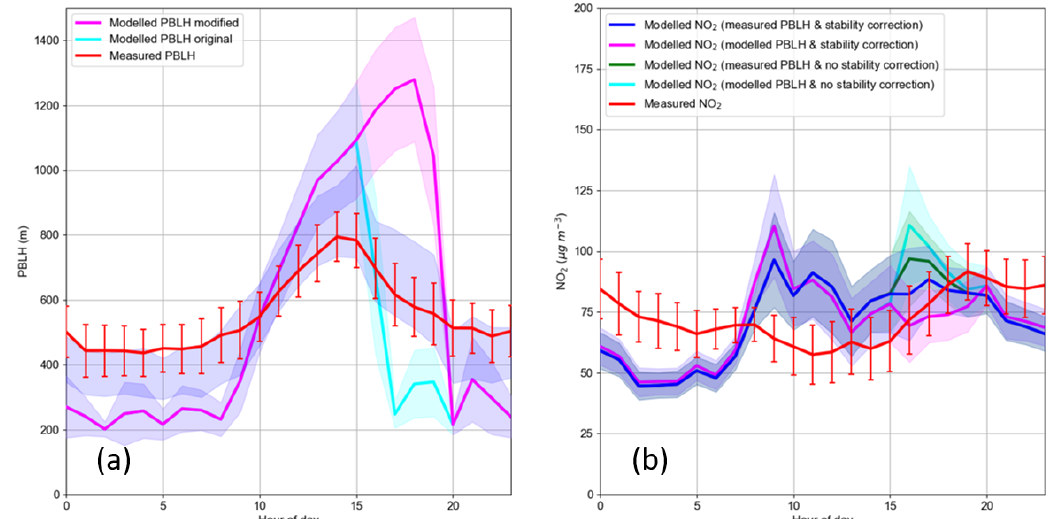
Figure 19. (a) Campaign period mean diurnal variation in modelled PBLH with stability correction (pink), modelled PBLH without stability correction (cyan) and measured PBLH (red). (b) Campaign period mean diurnal variation in measured (red) and modelled NO 2 concentrations with measured PBLH and stability correction (blue), modelled PBLH with stability correction (pink), measured PBLH without stability correction (green), and modelled PBLH without stability correction (cyan) at the IAP field site. Shaded areas and error bars represent the 95% confidence intervals for simulated and measured PBLH and concentrations,